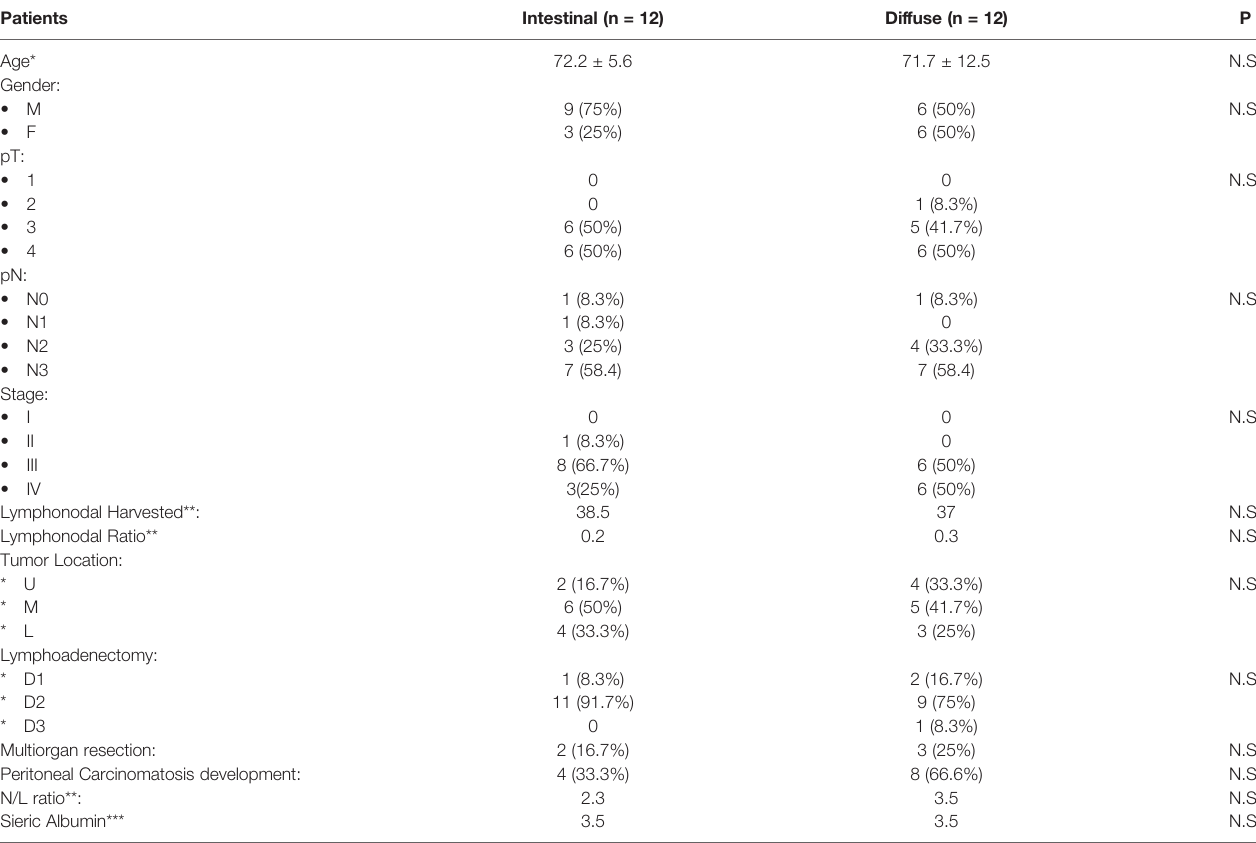
TABLE 1 | Clinical and pathological characteristics of the study population (n = 24).